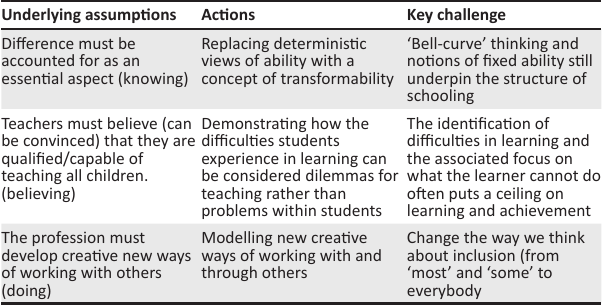
TABLE 1 : Inclusive pedagogical approach in action